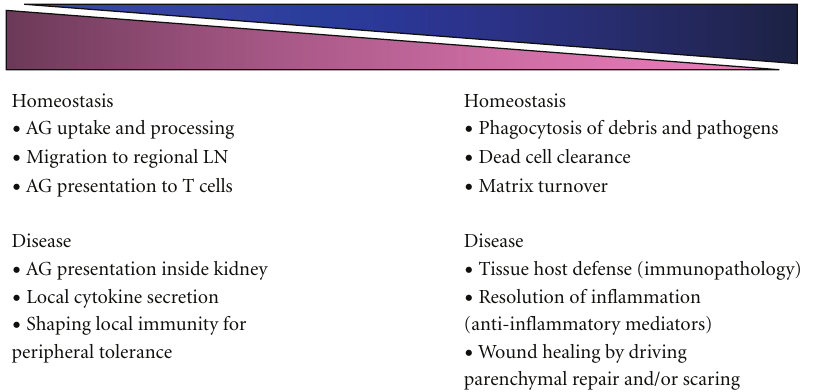
Figure 1: Roles of resident dendritic cells and tissue macrophages in homeostasis and disease. AG: antigen; LN: lymph nodes.